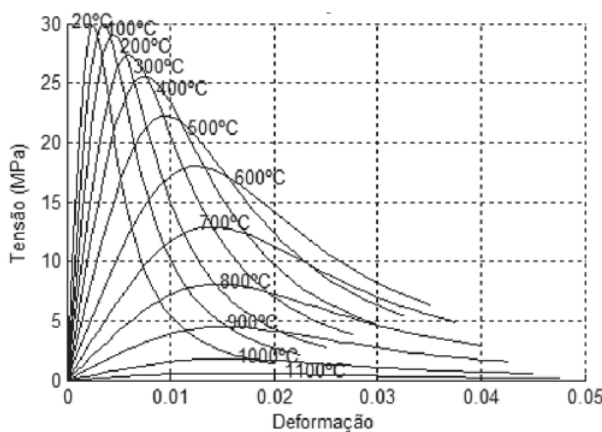
Figura 12 Diagrama tensão-deformação do concreto variando com a temperatura